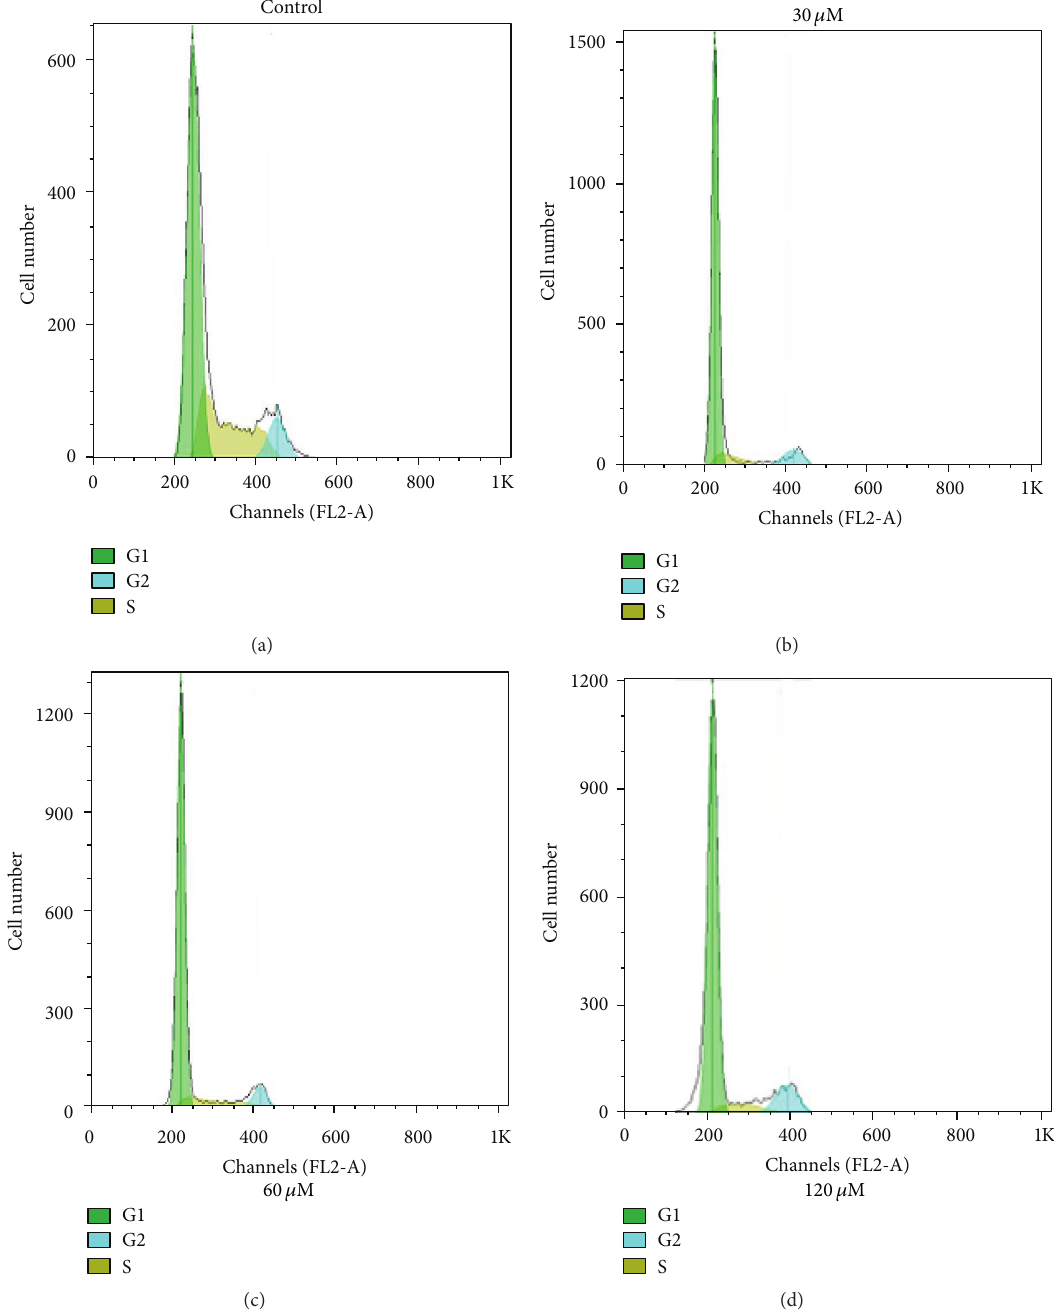
Figure 5: DNA content and cell cycle analysis of BEL-7402 cells after complex 1 treatment. BEL-7402 cells were cultured with either 0.1% DMSO(control),30 𝜇 M,60Mm,and120 𝜇 Mofcomplex 1 for48h.Thepercentageofnonapoptoticcellswithineachcellcyclewasdetermined by flow